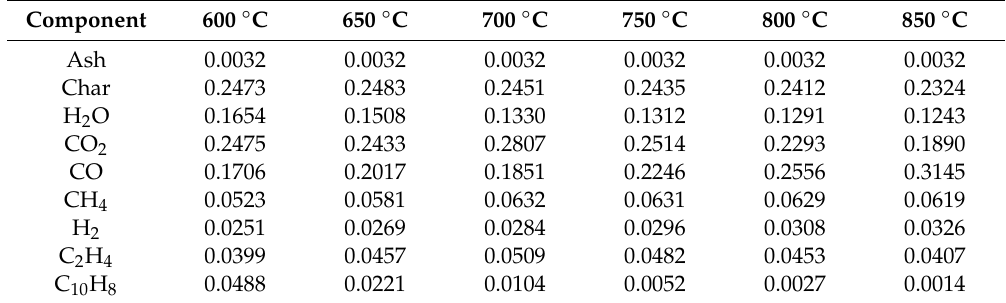
Table A1. Mass fractions ( ω j ) of products from biomass pyrolysis in the temperature range of 600–800 ◦ C; values from Fagbemi et al. [34] adapted for pyrolysis of wood pellets.